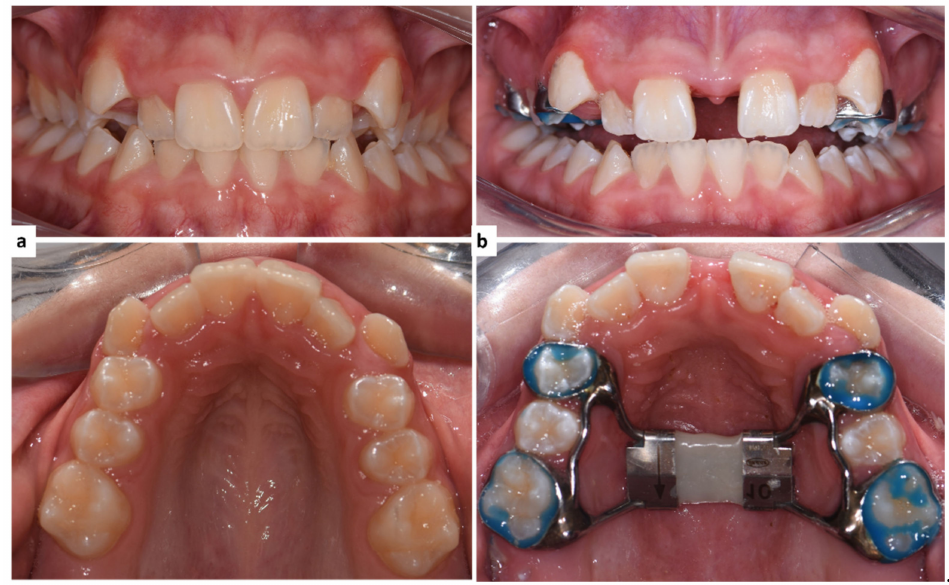
Figure 1. Intraoral photographs of a patient. ( a ) Before the cementation of the Hyrax expander. ( b ) After the expander was blocked for